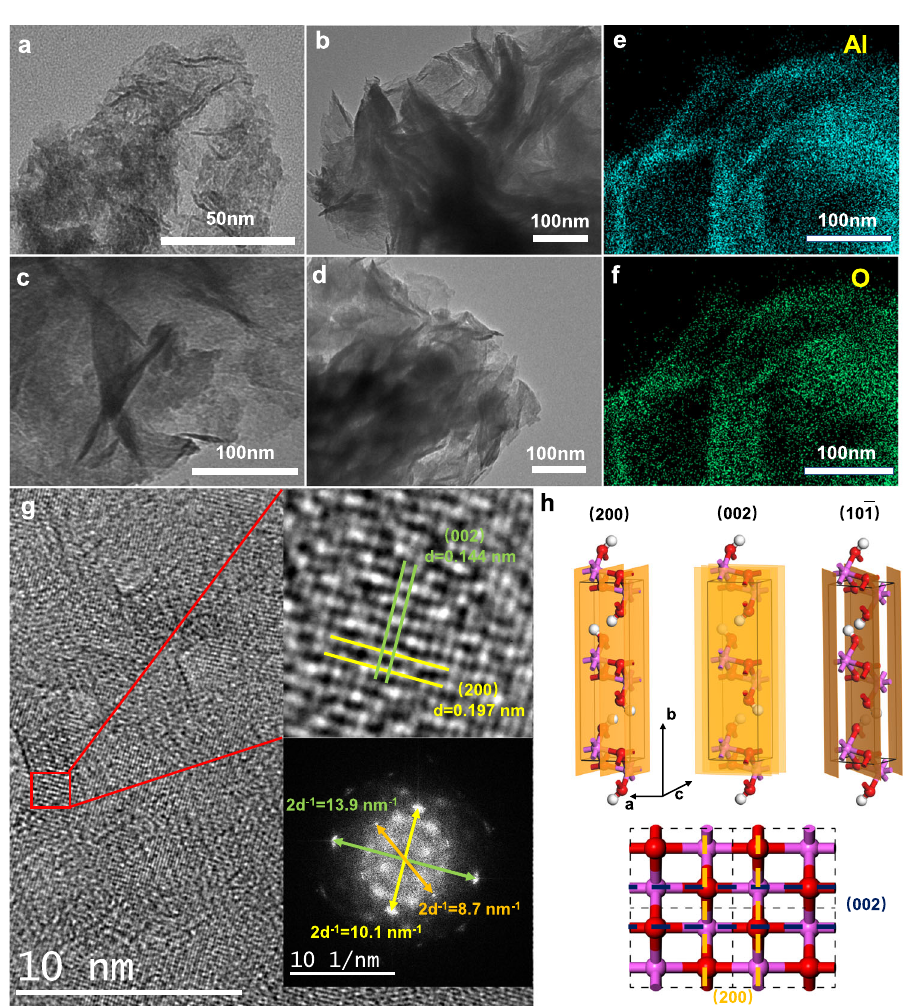
Fig. 2 TEM and HR-TEM images for catalysts. a AlOx-U1. b AlOOH-U2. c AlOOH-U3. d AlOOH-U4. e Al and f O EDS elemental mapping images of